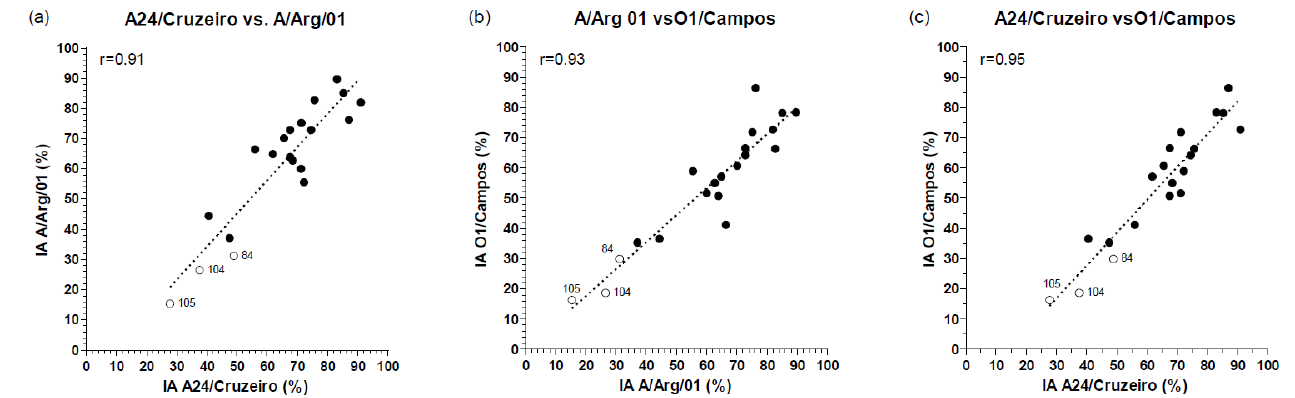
Figure 9. Correlation of avidity indexes against different FMDV strains in serum samples from vaccinated animals at 30 dpv. The AI of the FMDV-specific IgG antibodies measured against the A24/Cruzeiro, A/Arg/01 and O1/Campos strains in each vaccinated animal were analyzed by pairs using a Pearson’s correlation test, as indicated in each panel. White circles denote non- protected animals (#84, #104, #195), and the corresponding Pearson’s r values are shown in each graph ( p value <